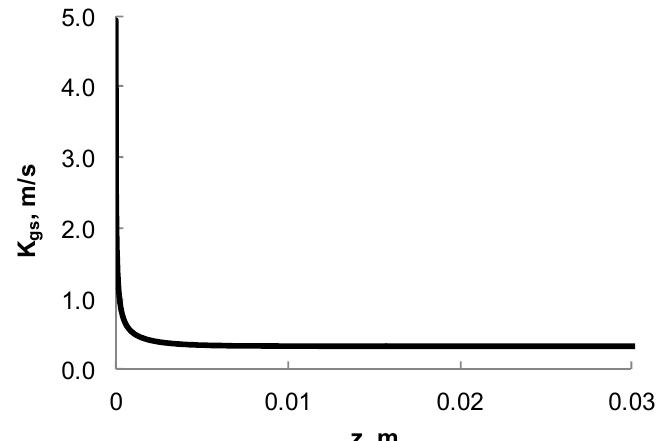
Figure 1. Typical profile of mass transfer coefficient along the monolith cell length.